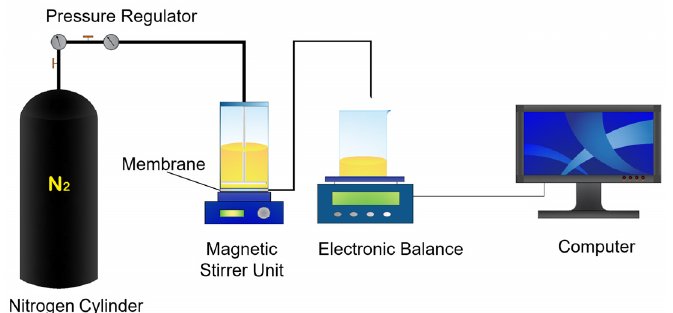
Figure 1. The schematic diagram of the ceramic membrane cross-flow filtration dead-end filtration. The membrane morphology and element mapping images were imaged by SEM